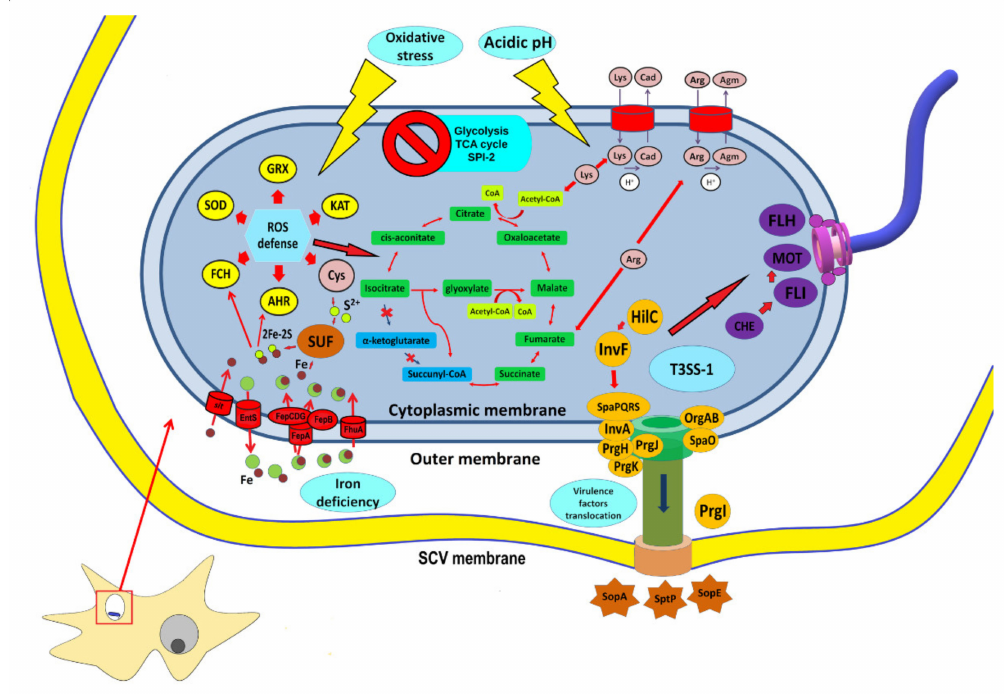
Figure 3. Reconstruction of the main metabolic and functional systems of S . Typhimurium responsible for A . castellanii infection. Enzymes involved in oxidative stress response are highlighted in yellow. Oxidoreductases included in Fe-S clusters (2Fe-2S) activating iron uptake system are in red ( ent , fhu , and fep ). Fe-S cluster assembly systems (SUF) are in brown. Glyoxylate shunt (GS; green) was shifted to the tricarboxylic acid (TCA) cycle and induced by reactive oxygen species (ROS). Low pH activates arginine (Arg) and lysine (Lys) metabolism (pink). Upregulation of SPI-1 genes (orange), flagellar apparatus (purple), and chemotaxis (purple) operons indicate that Salmonella penetrates protozoan cells. GRX, glutaredoxin 1; KAT, catalase G; AHR, alkyl hydroperoxide reductase; FCH, ferrochelatase; SOD, superoxide dismutase; SUF, Fe-S cluster assembly; Cys, cysteine; Lys, lysine; Cad, cadaverine; Arg, arginine; Agm, agmatine; FLH, flagellar assembly proteins flh; MOT, stator proteins MotAB; FLI, flagellar assembly proteins fli; CHE,